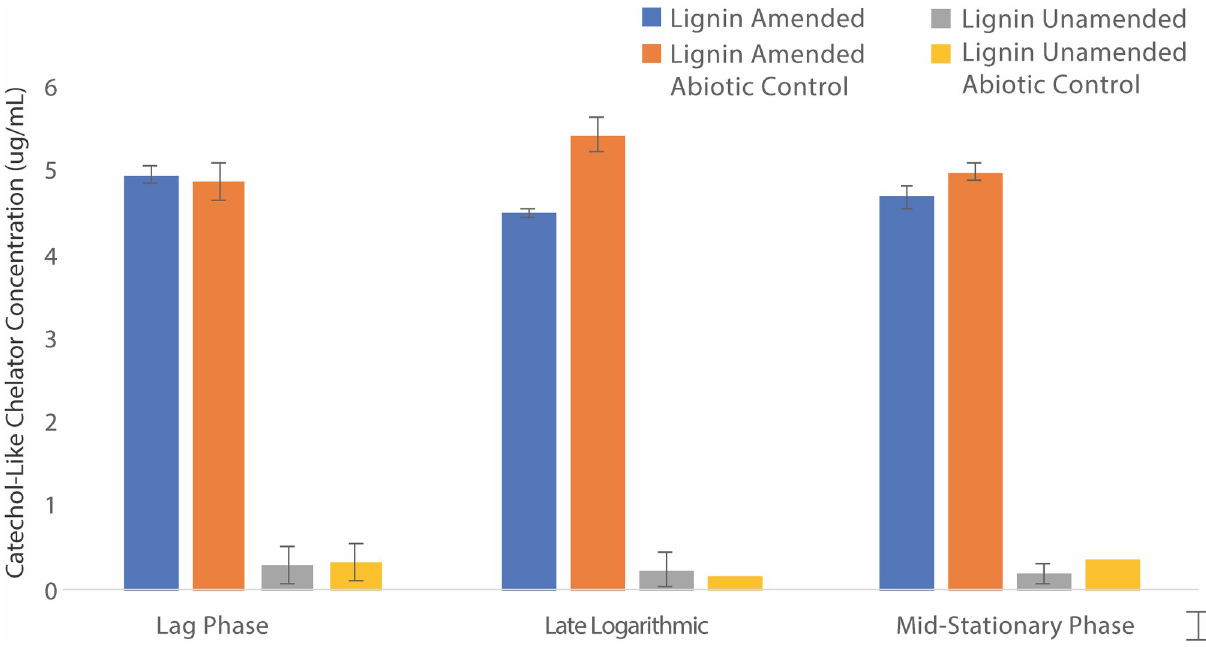
Fig 6. Arnow assay of catechol-like compounds present in supernatant. Catechol-like chelator concentrations ( μ g/mL; ± SD) at lag, late logarithmic, and mid-stationary phase of BRL6-1 growth under lignin-amended (blue) and unamended conditions (gray). Abiotic controls are striped for both conditions (n = 3 for each treatment, n = abiotic